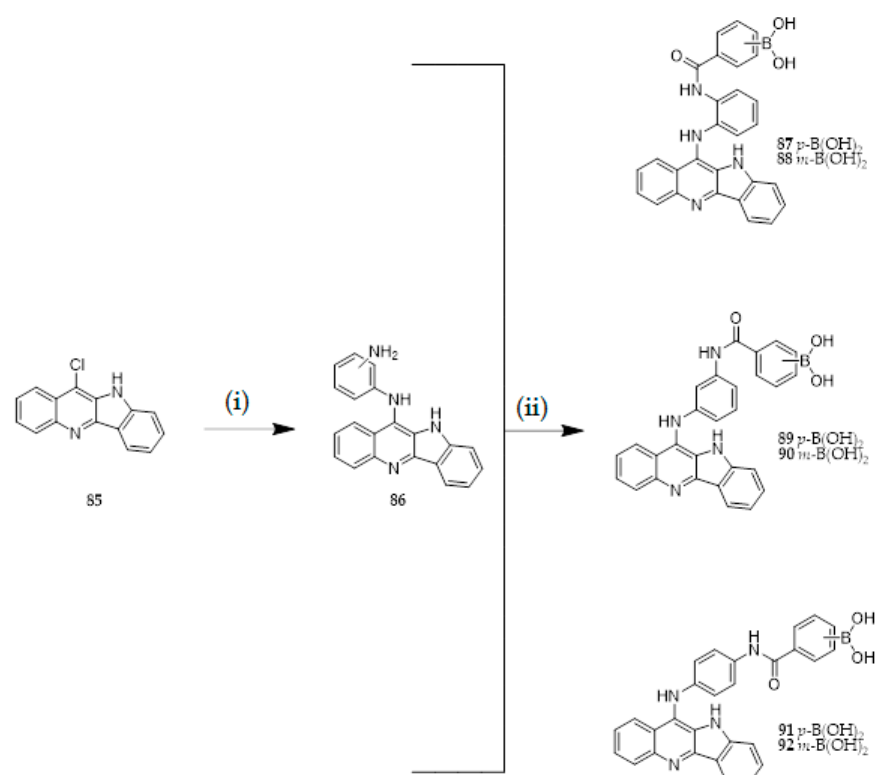
Scheme 20. Synthesis of boronic acid derivatives 87 – 92 as IAV replication inhibitors. Reaction